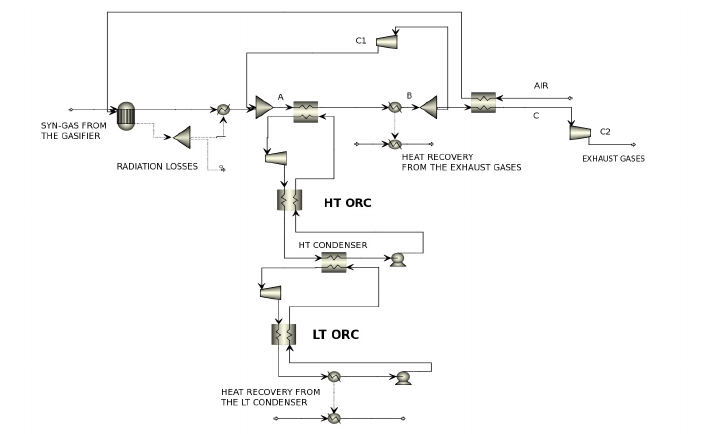
Figure 6. Plant scheme with a binary cycle